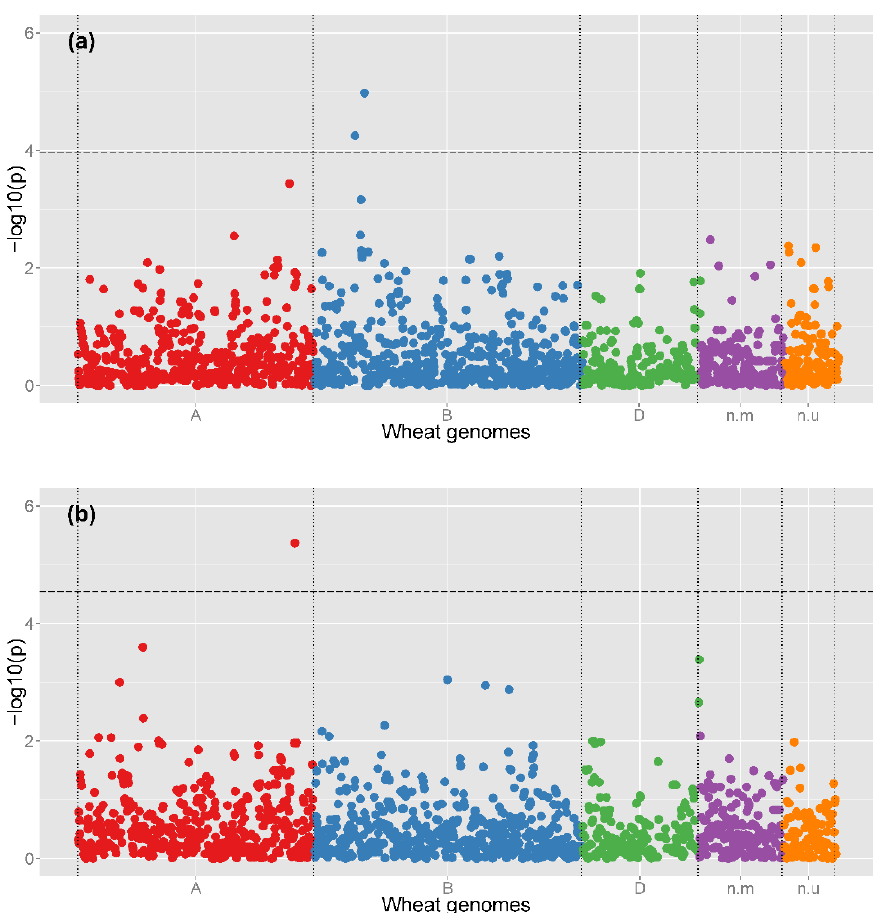
Figure 2. ”Manhattan” plot indicating the strength of marker trait associations between 1825 DArT markers and common bunt resistance data from ( a ) the year 2011 (log1–9 scale), ( b ) the mean of the years 2011 and 2012 (log1–2 scale) in a population of 248 wheat accessions. The y -axis shows − log10 transformed p -values of the association test. Markers are grouped by A, B and D genome, respectively. Markers which were not mapped (n.m) or not unique (n.u) in their chromosomal locations are indicated. The dashed horizontal line indicates the 95th percentile of p -values from 20,000